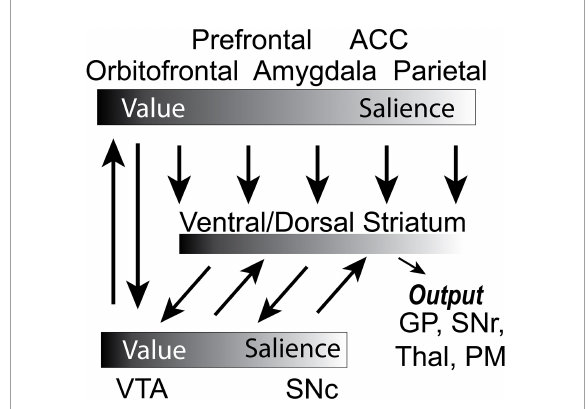
FIGURE1 Circuit diagram of decision-making circuit. Gradients denote whether the corresponding brain region better encodes value or salience. Arrows represent the flow of information. PM, premotor cortex; SNc, substantia nigra compacta; GP, globus pallidus; Thal, thalamus; SNr, substantia nigra reticulata; VTA, ventral tegmental area. Adapted from Gentry et al.